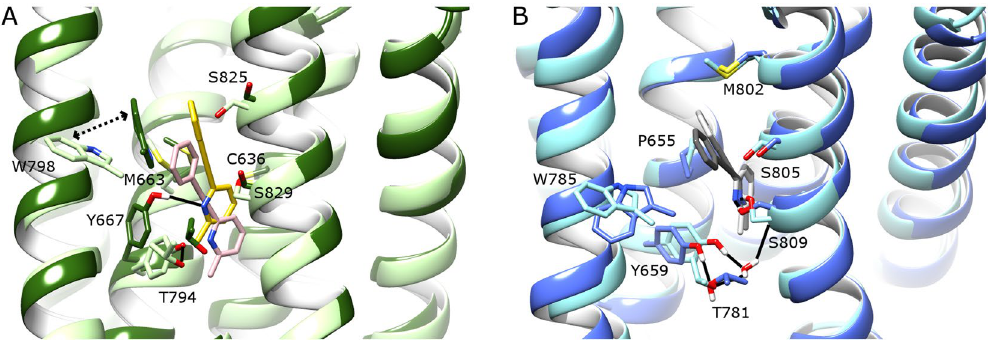
Figure 5. Comparison of bound MPEP in ( A ) mGlu4 and ( B ) mGlu5, before and after respective MD simulations (average conformations calculated from 2.5–5 µ s). Colours as follows: ( A ) MPEP before MD in pink, MPEP after MD in yellow, mGlu4 before MD in light green, mGlu4 after MD in dark green; ( B ) MPEP before MD in dark grey, MPEP after MD in light grey, mGlu5 before MD in light blue, mGlu5 after MD in blue. Selected residues delineating allosteric pockets or participating in ligand binding are labelled. Protein-ligand H-bonds are represented by solid black lines. The inward movement of W798 in mGlu4 is indicated with a dotted arrow. Helix orientations as follows: TM5 left, TM3 centre-left, TM7 centre-right, TM1 right. TM6 backbone is hidden.